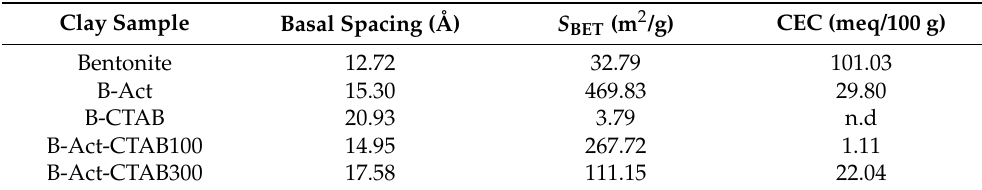
Table 2. Summary of data for the d 001 reflexion (basal spacing), cation exchange capacity (CEC), and S BET for all samples